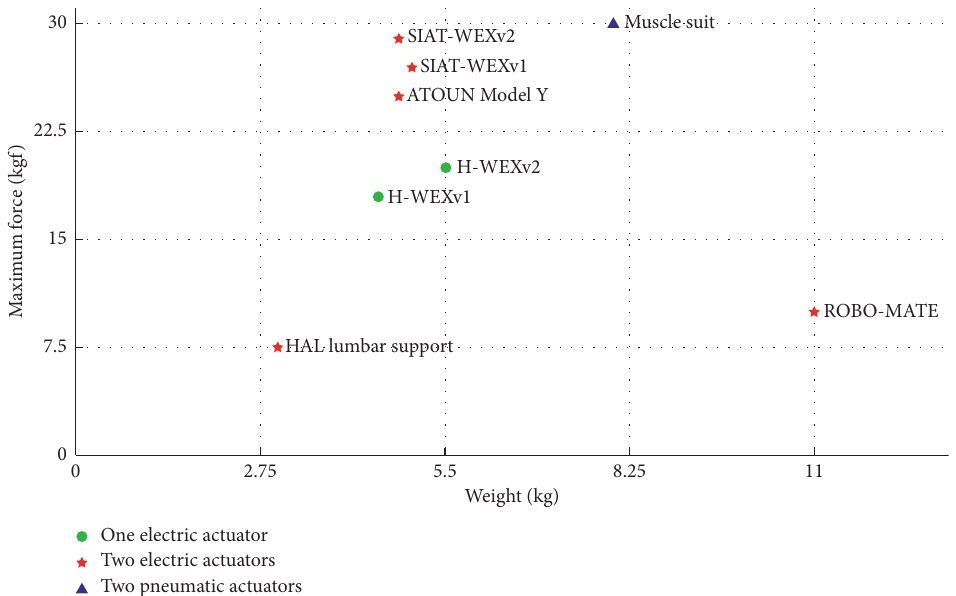
Figure 1: Comparison chart for maximum assistive forces with respect to weights of several lumbar